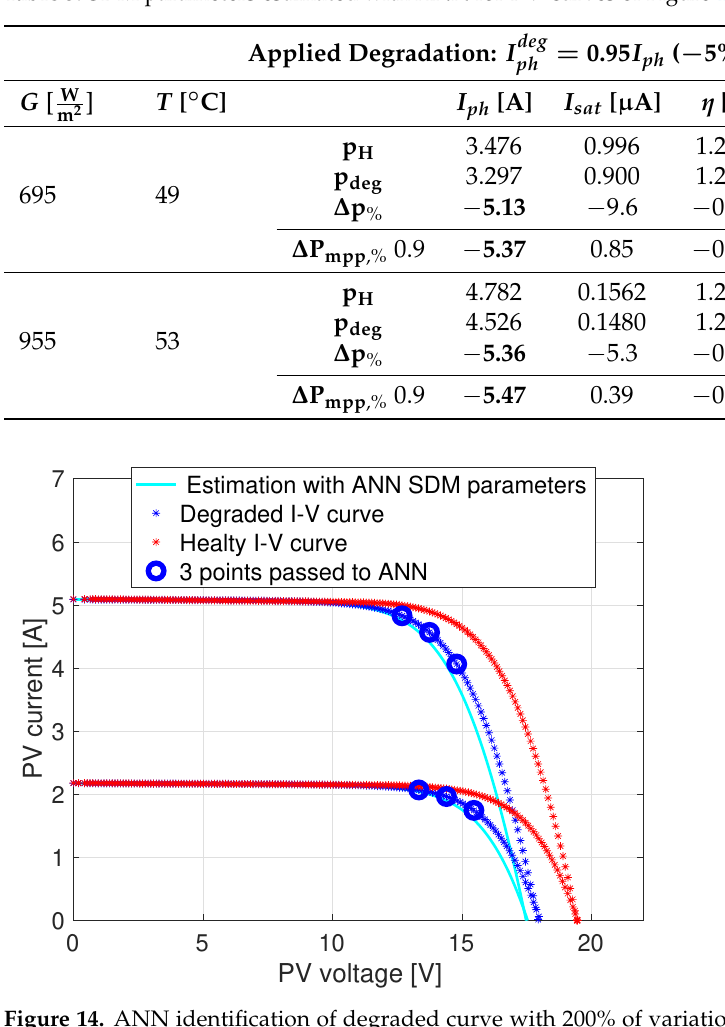
Figure 14. ANN identification of degraded curve with 200% of variation on I sat for two different irradiance and temperature